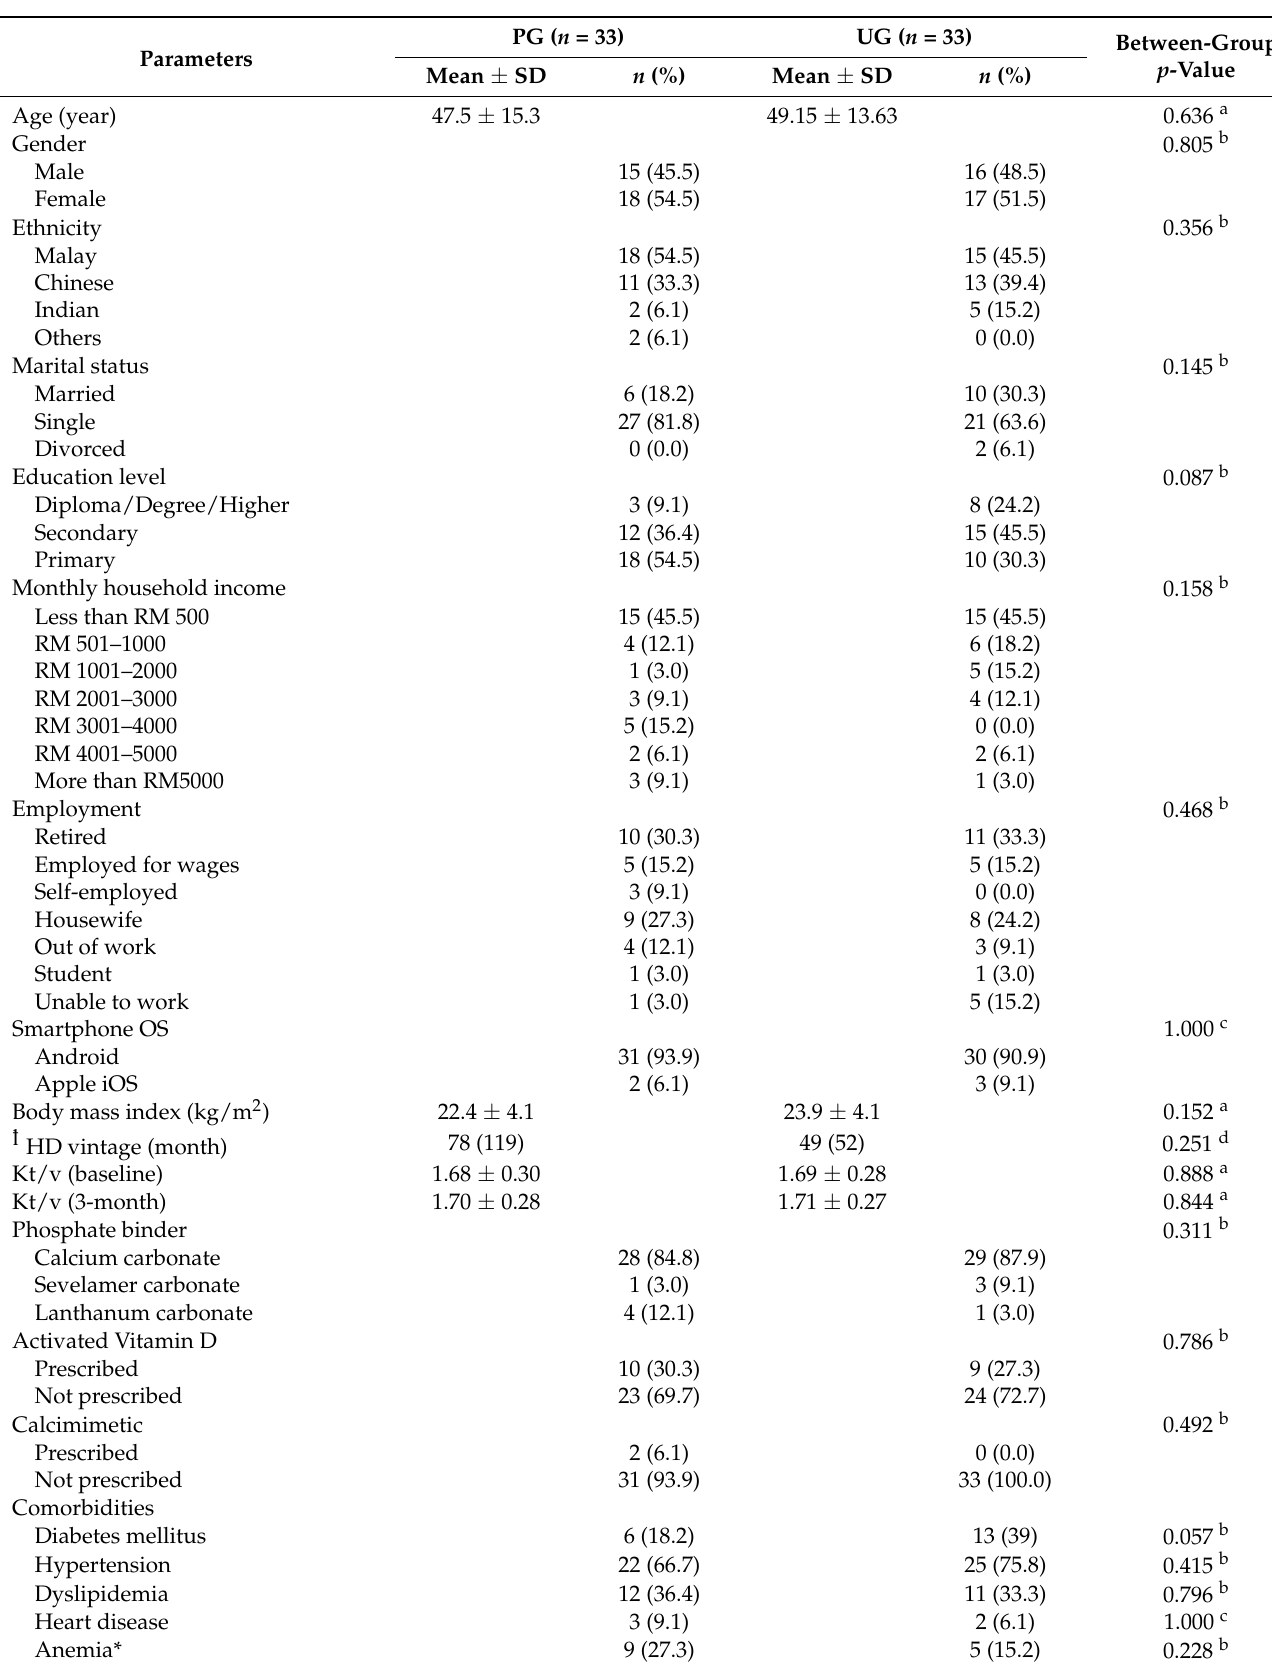
Table 1. Patients’ baseline characteristics and biochemical parameters ( n = 66).